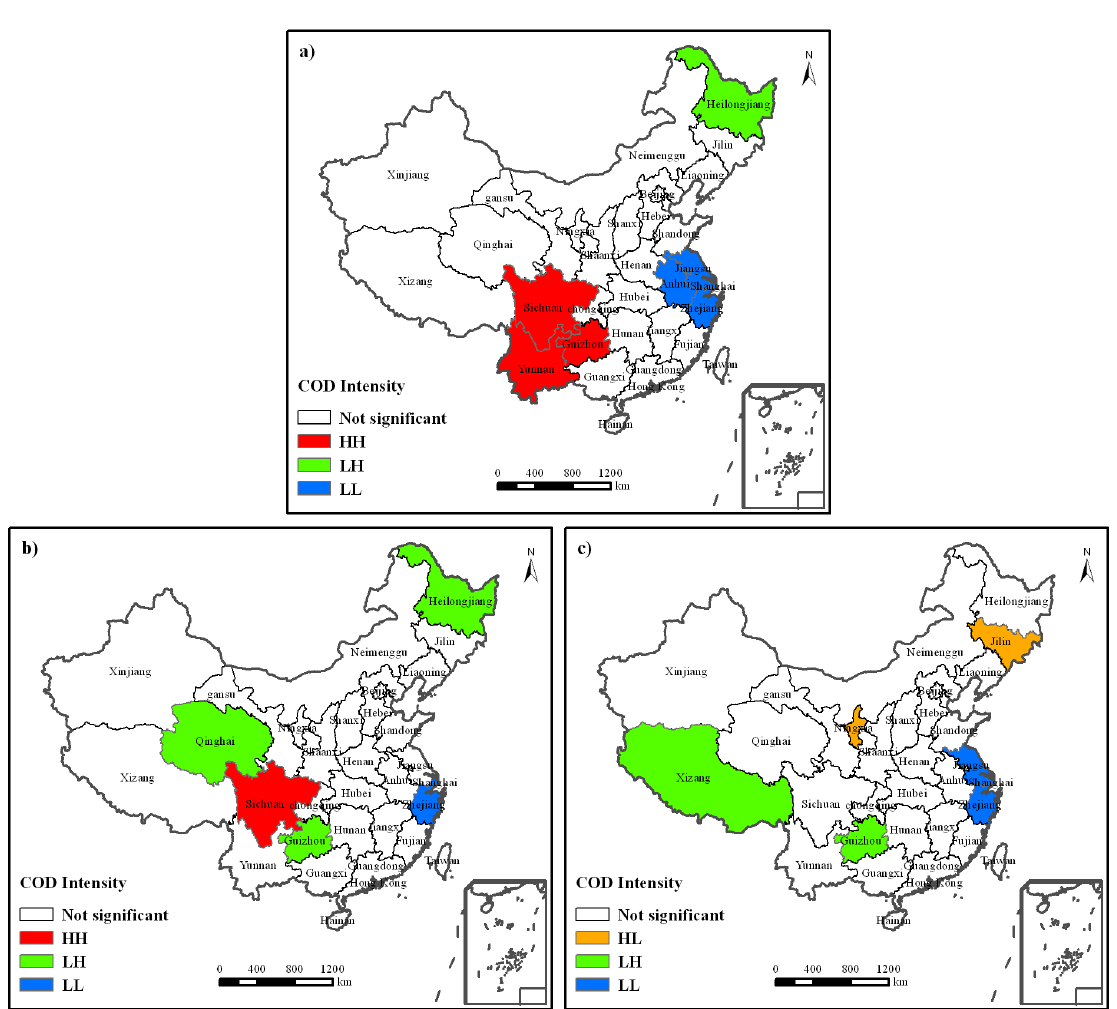
Figure 5. LISA cluster map of industrial COD discharge intensity. Temporal and spatial variations of industrial COD discharge amount are divided into three phases. ( a ) Its status during the “9th Five-Year” period; ( b ) Its status during the “10th Five-Year” period and ( c ) Its status during “11th Five-Year” period. The meaning of HH, HL, LH, LL is like those in Figures